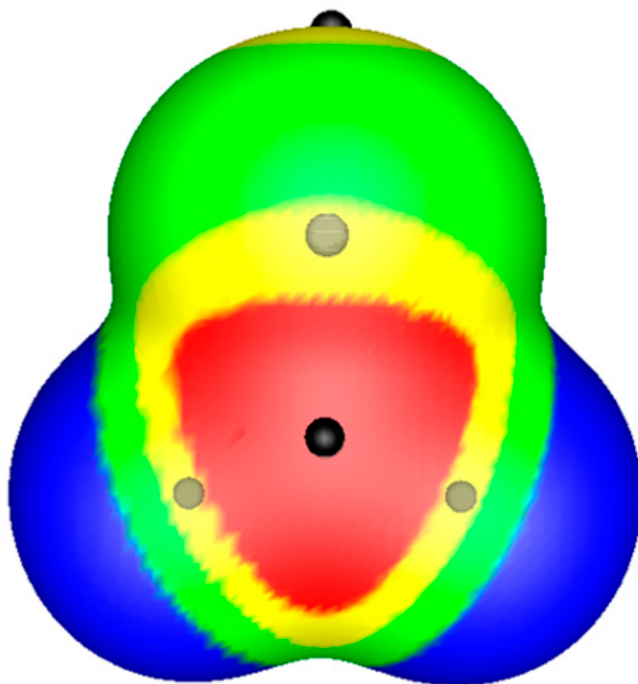
Figure 3. Computed electrostatic potential on 0.001 au molecular surface of P(Cl)O 2 , which is planar. The phosphorus is at the center, the chlorine is at the top. Gray circles indicate positions of nuclei. Black hemispheres show locations of V S,max ; there is one directly above and below the phosphorus nucleus, due to a π -hole, and one on the chlorine, corresponding to a σ -hole on the extension of the P–Cl bond. Color ranges, in kcal/mol: red, more positive than 26; yellow, between 26 and 13; green, between 13 and 0; blue, negative.